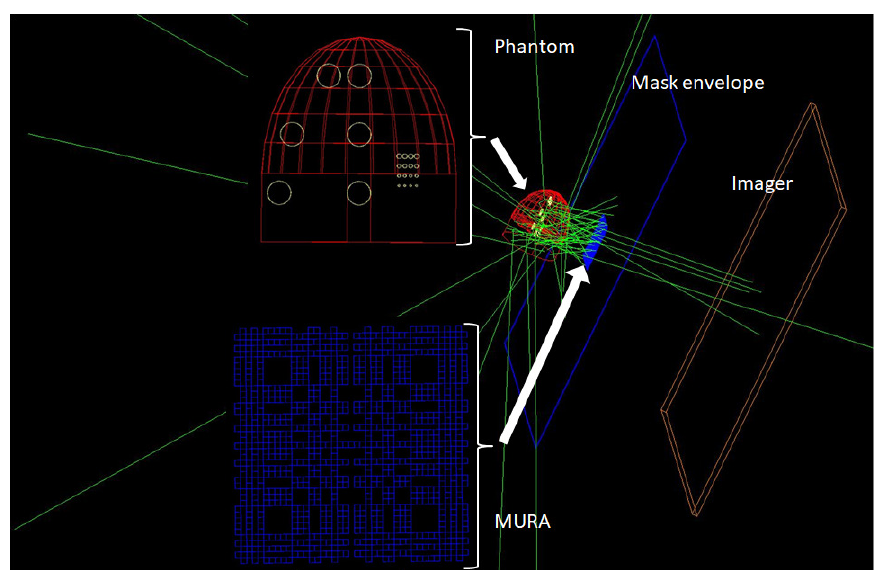
Figure 2. Geant4 setup visualization including the breast model (red), the MURA mask (blue), the imaging detector (orange) and the scattered photons trajectories (green lines). Zoomed out phantom and mask were also shown.